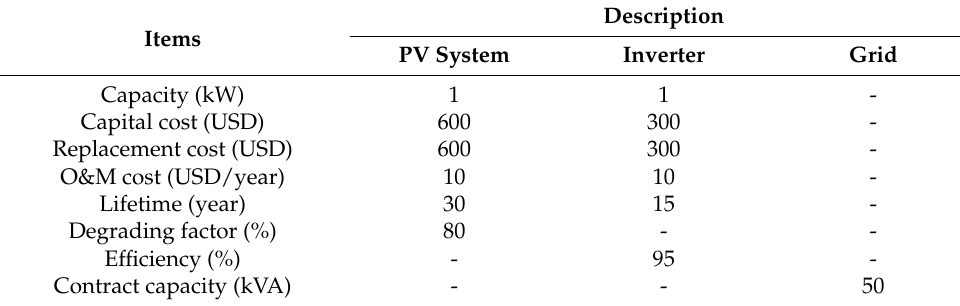
Table 2. Components and its specification in the case